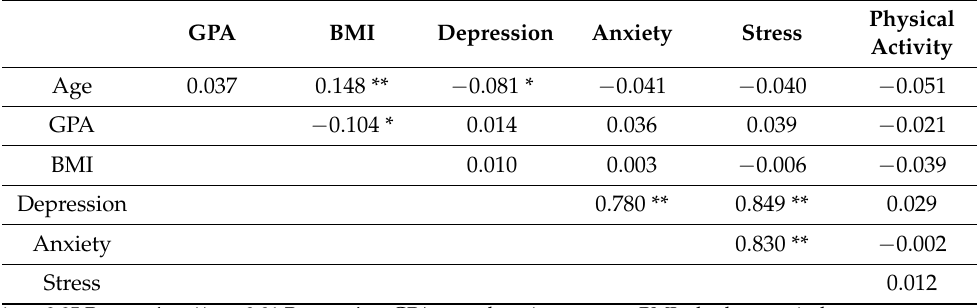
Table 3. Correlations between age, GPA, BMI, scores of the DASS-21, and Physical Activity (GSLT- PAQ) scales (N =